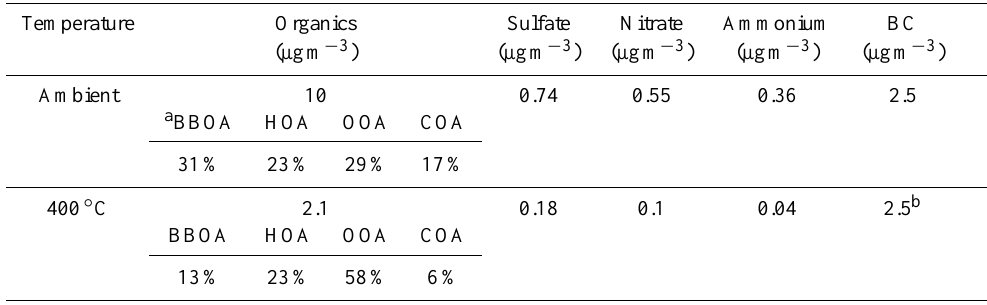
Table 3. Average mass concentration of major species when the TD was set at 400 ◦ C (given for ambient conditions and after 400 ◦ C) during the Athens 2013